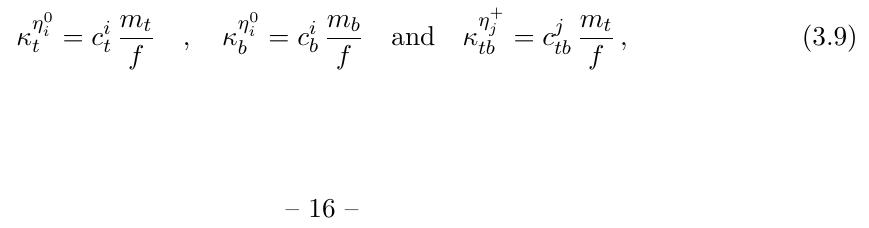
Figure 6. Overview of the pNGB decays in the fermiophobic case (continued from figure 5). The neutral triplet component decays into three gauge bosons, as it does not couple to the